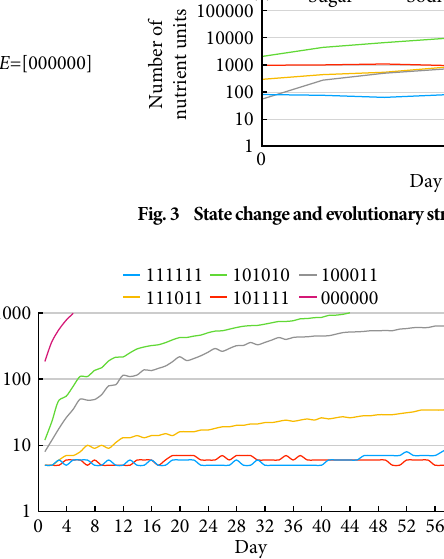
Fig. 4 Comprehensive state changes of agents in different evolutionary cannot be ignored. The evolutionary examples in Figs. 2−4 are all